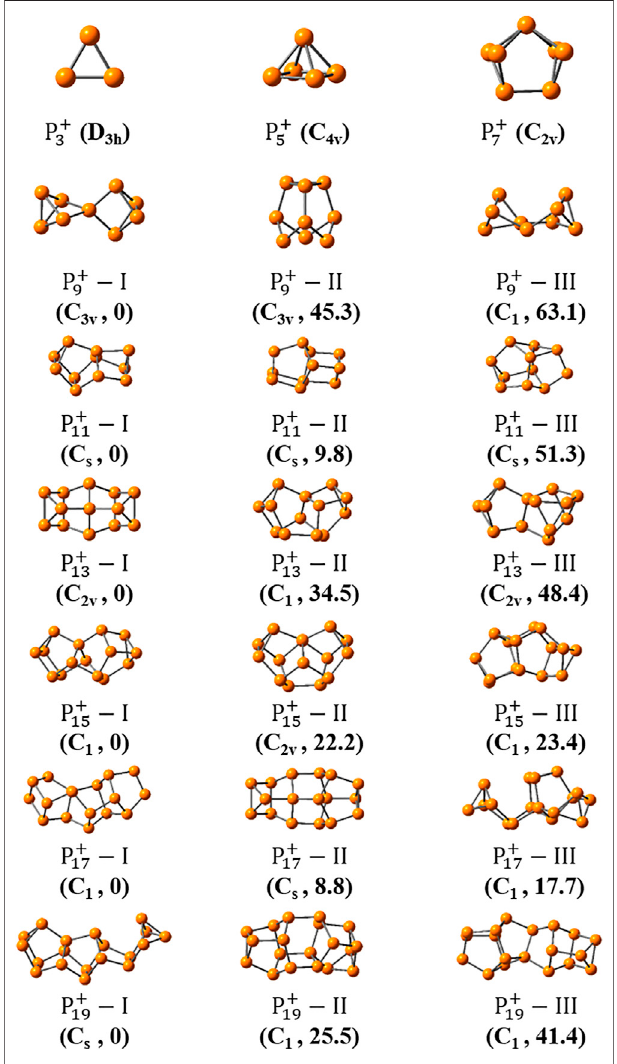
FIGURE 3 | The most stable isomers of P + 2n + 1 ( n (cid:2) 1 – 9) searched by the NKCS program. The three most stable isomers are identi fi ed as P + 2n + 1 − I, P + 2n + 1 − II, and P + 2n + 1 − III, in turn. Their symmetries and relative energies (in kJ/ mol) to corresponding global minima are shown below.